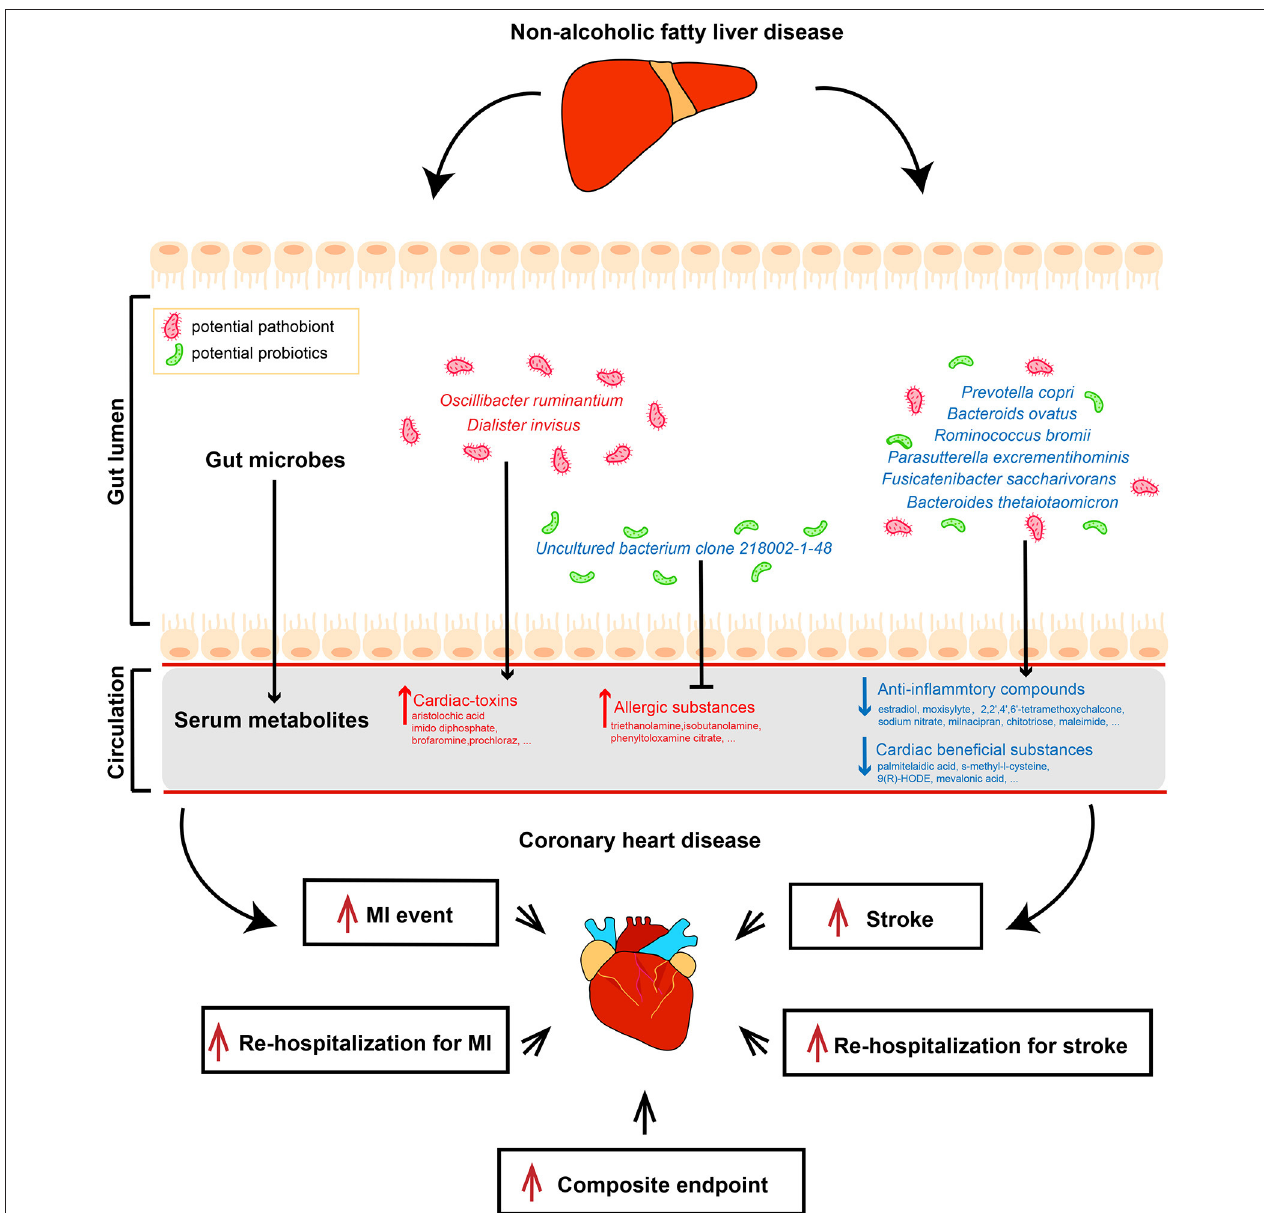
FIGURE 5 | Multi-omics analysis illustrates the interrelationship between non-alcoholic fatty liver disease and coronary heart disease. Features colored in red represent increase in corresponding gut microbiome or serum metabolites. Features colored in blue represent depletion in corresponding gut microbiome or serum metabolites. Arrows represent significant correlations between